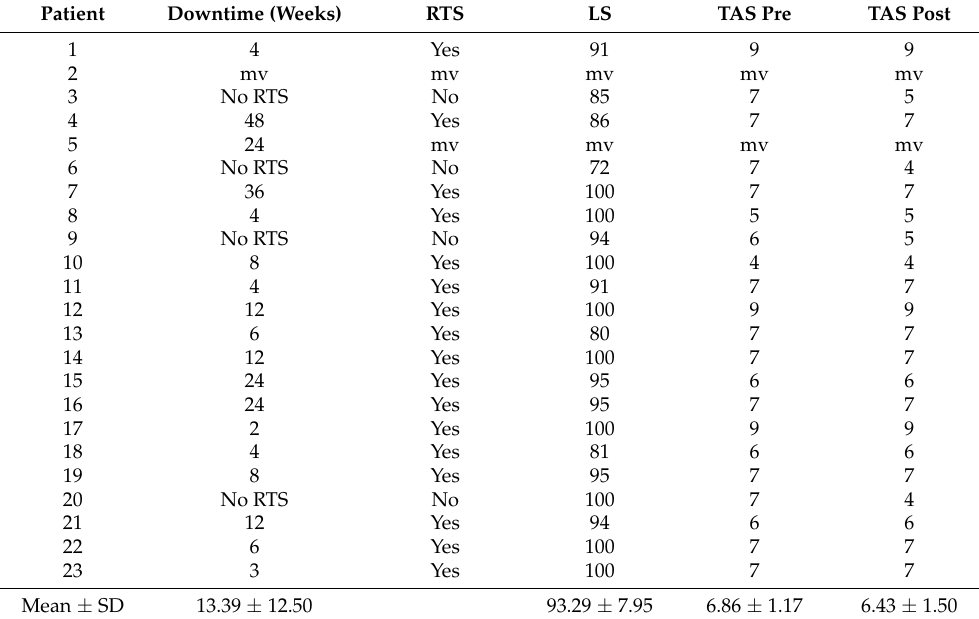
Table 3. Downtime in preferred sports, RTS as well as results of LS and TAS at follow up for every single patient ( n = 23). Incomplete data for patients no. 2 and no. 5 are lost to follow up. Patient Downtime